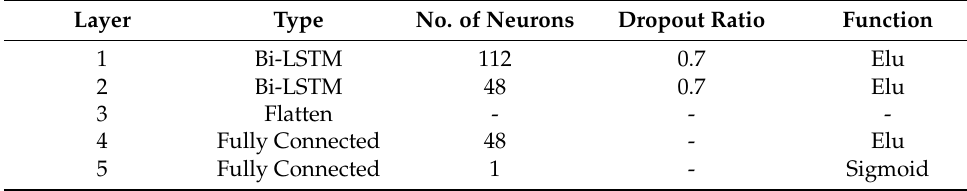
Table 3. A summary table of the proposed Bi-LSTM